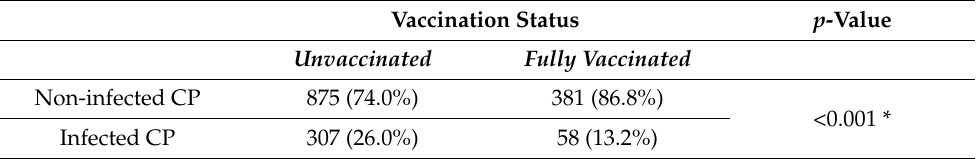
Table 4. Influence of CP (contact person) vaccination status on infection status; * Chi-squared-test.